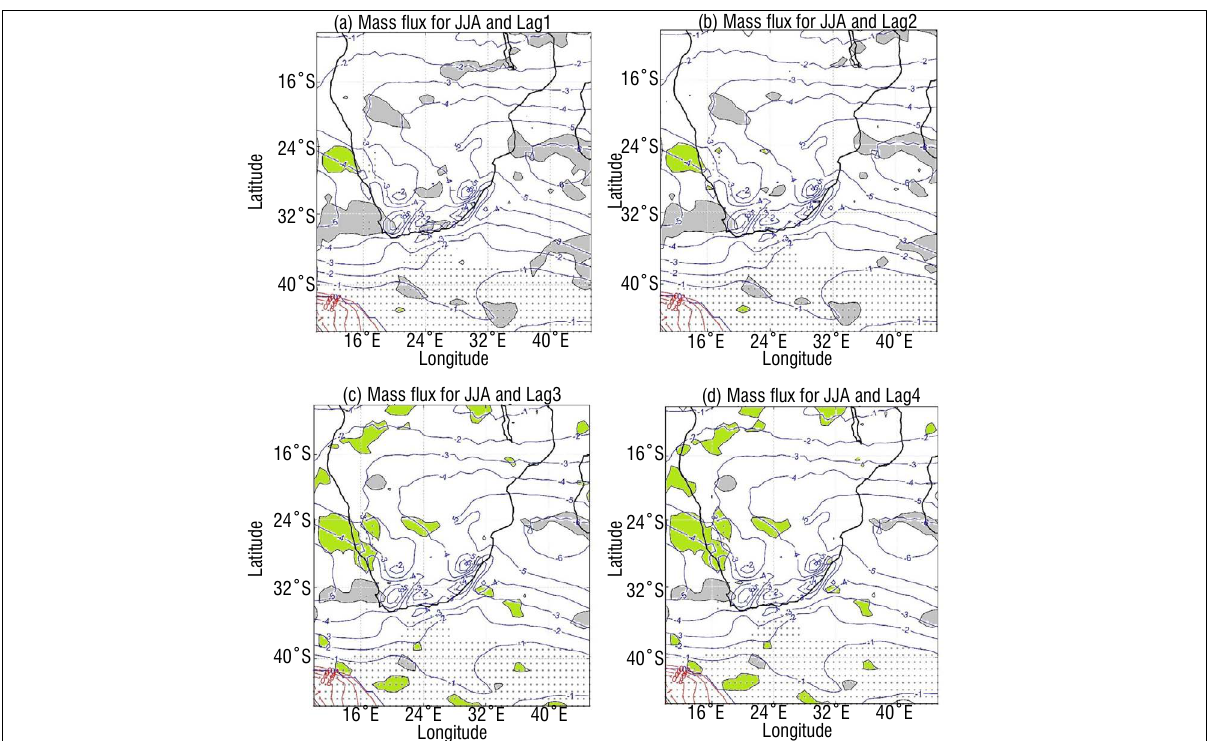
Figure 5: Seasonal mean of (a–d) the mass flux (m ϕ ) in June–August (JJA); units are kg/m 2 s. Negative (positive) values of the mass flux are represented by the blue (red) contours. The contours are plotted in 10 3 kg/m 2 s intervals. Correlation coefficients for the Hadley cell and total cloud cover relation in JJA for (a) Lag 1, (b) Lag 2, (c) Lag 3 and (d) Lag 4. Grey shading denotes correlation coefficients greater than 0.3 and green shading indicates correlation coefficients less than -0.3. Regions of upward vertical velocity ( ω ) in Pa/s are represented by grey dots. Where there are no grey dots, there is downward motion (i.e. ω > 0). (a) Total Cloud Cover for DJF and Lag1